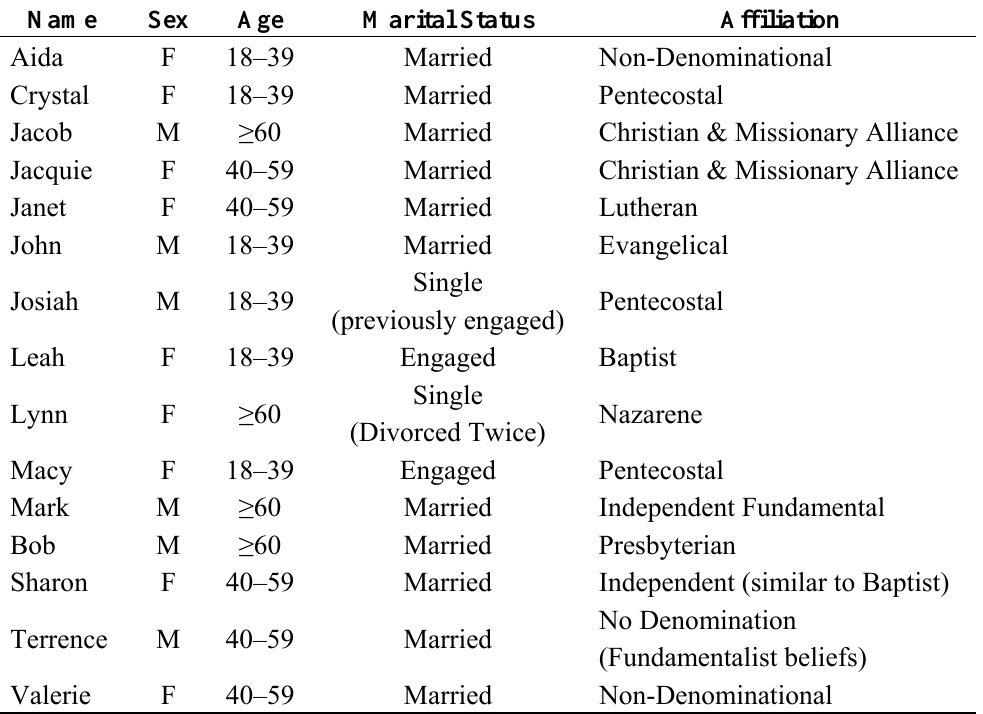
Table 1. Description of